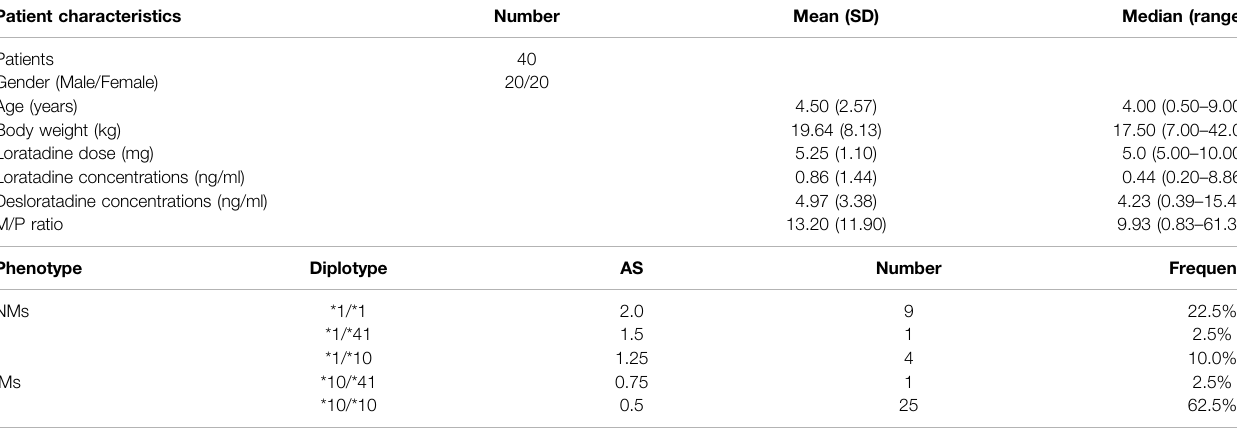
Range: Minimum value – Maximum Value. M/P ratio: the metabolite-to-parent ratio, the molar ratio of desloratadine to loratadine. AS, activity score.